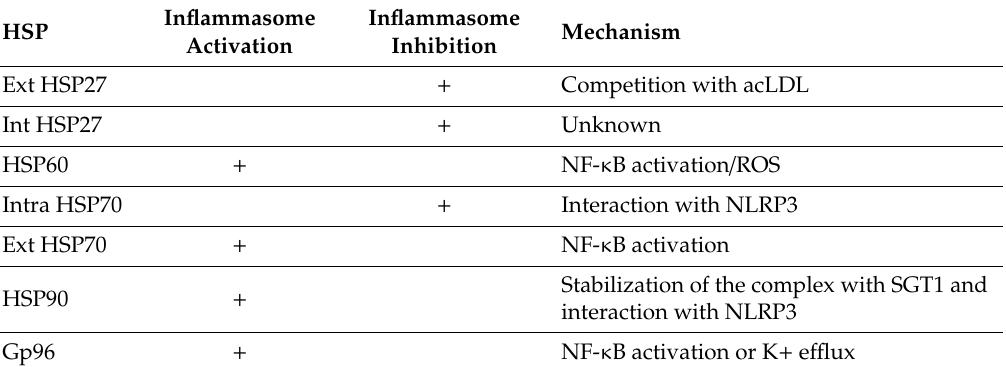
Table 1. E ff ects of HSP on the NLRP3